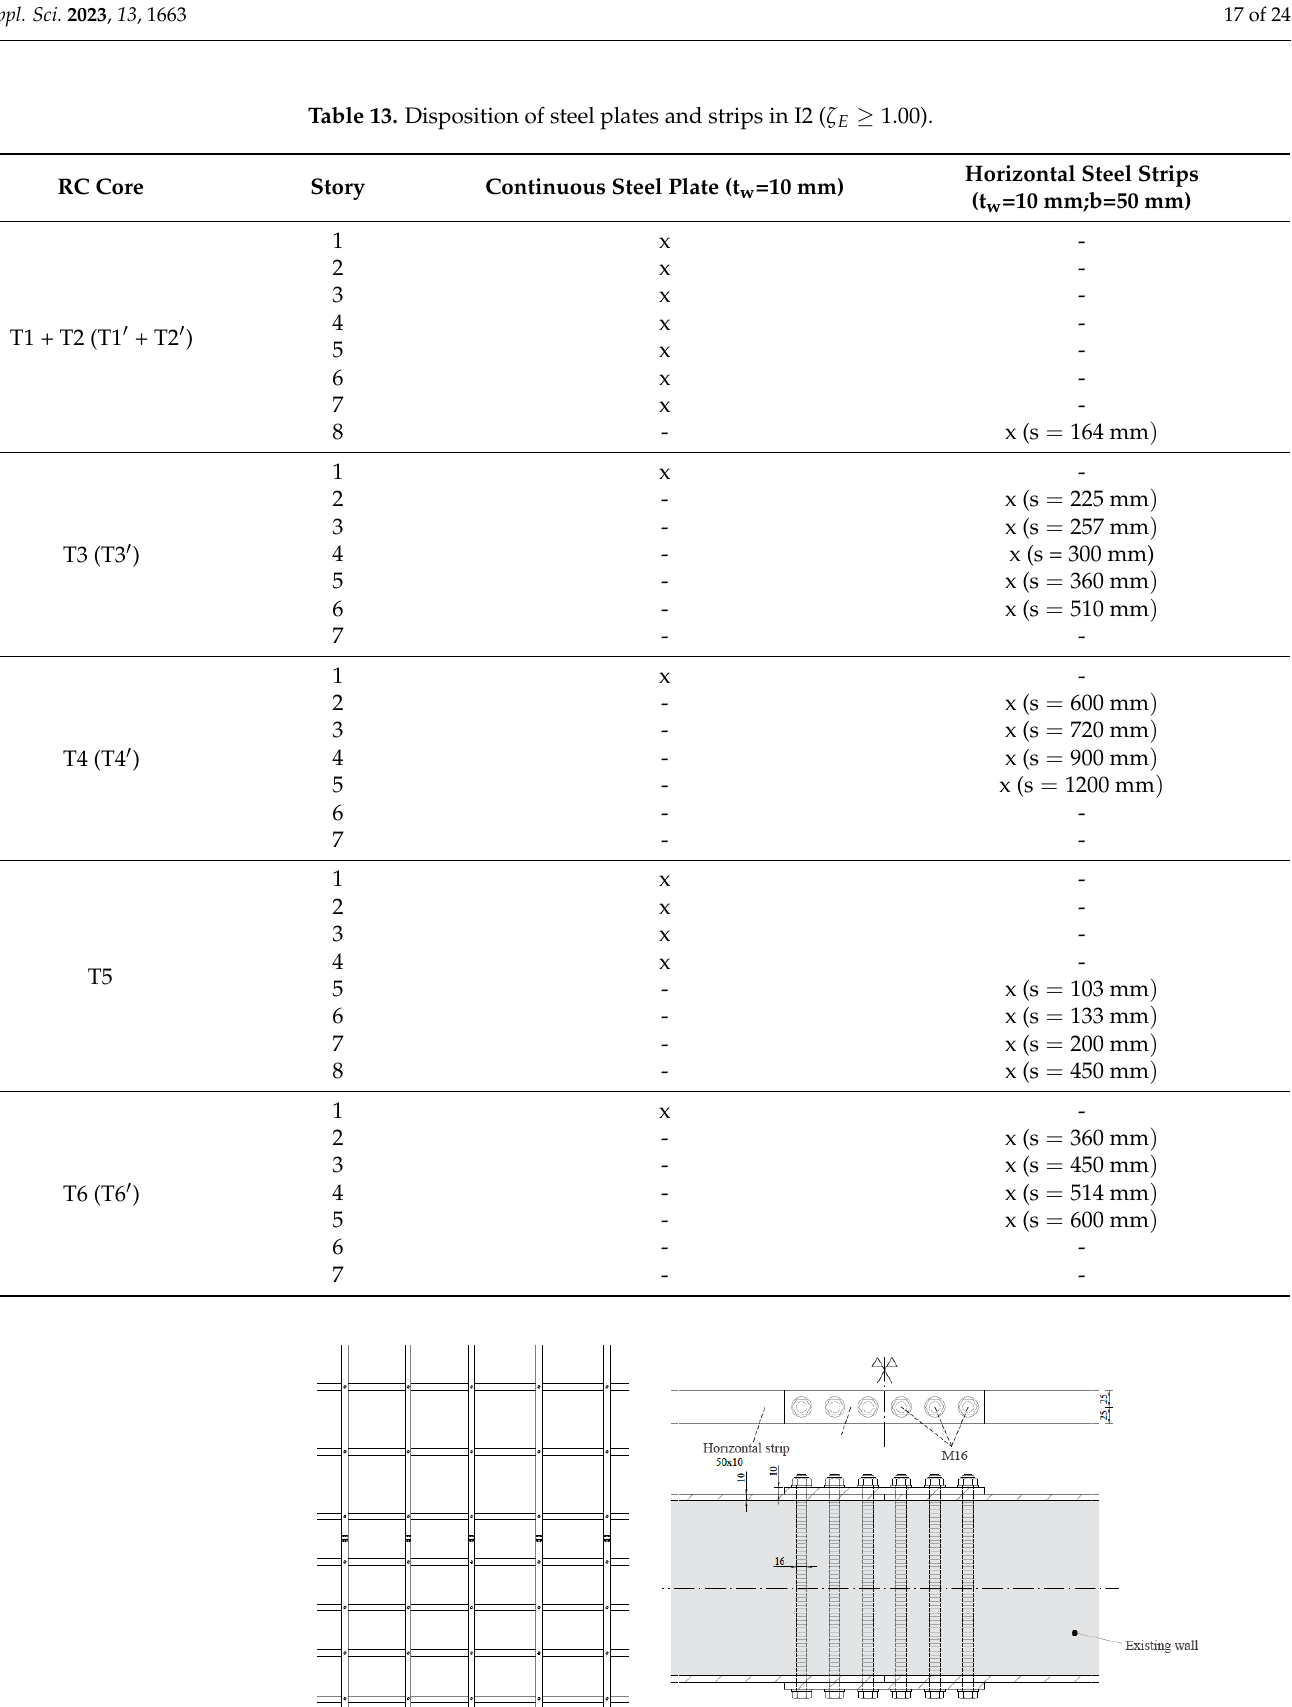
Figure 15. Structural detail of the horizontal steel strips applied to the concrete wall.